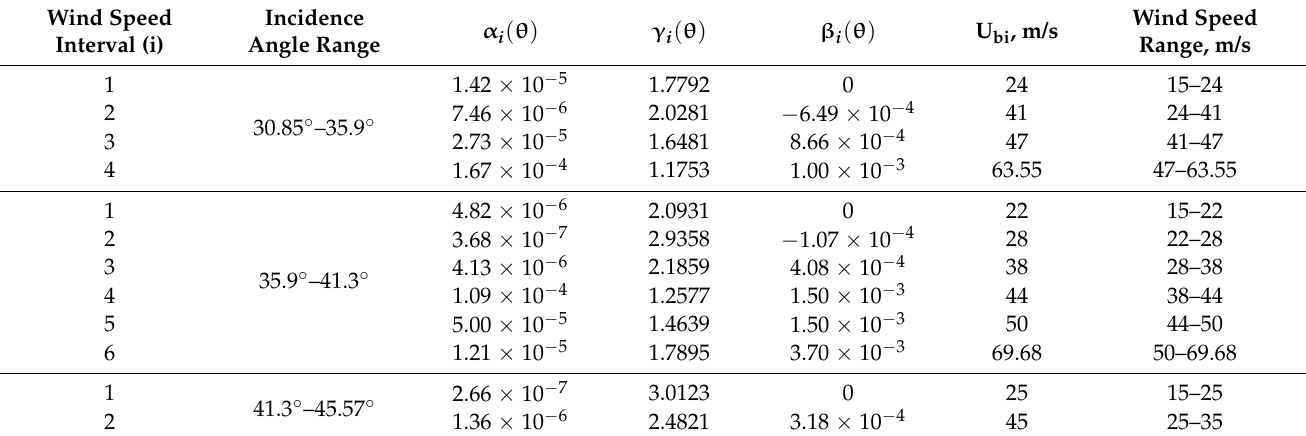
Table 2. The MADP-S1 power approximation coefficients used for the wind velocity